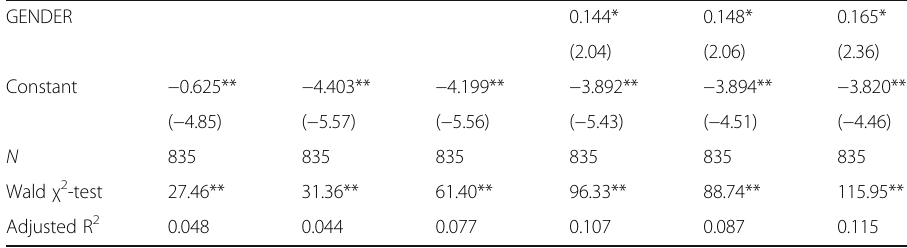
Table 3 Results from first stage regressions a (Continued)